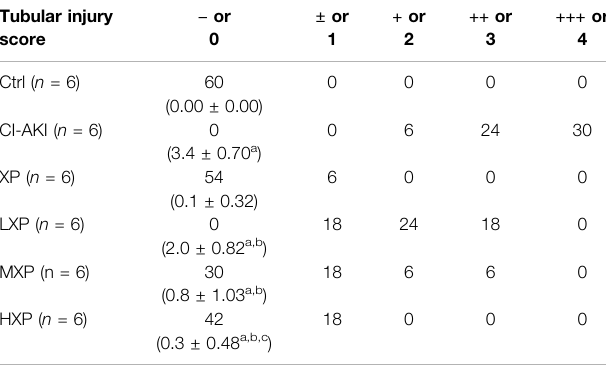
Descriptions of the groups are in the text. Ten consecutive ( × 400) fi elds of cortex and outer stripe of medulla were selected randomly from each sections in each group (60 fi elds in each group). a p < 0.05 compared with